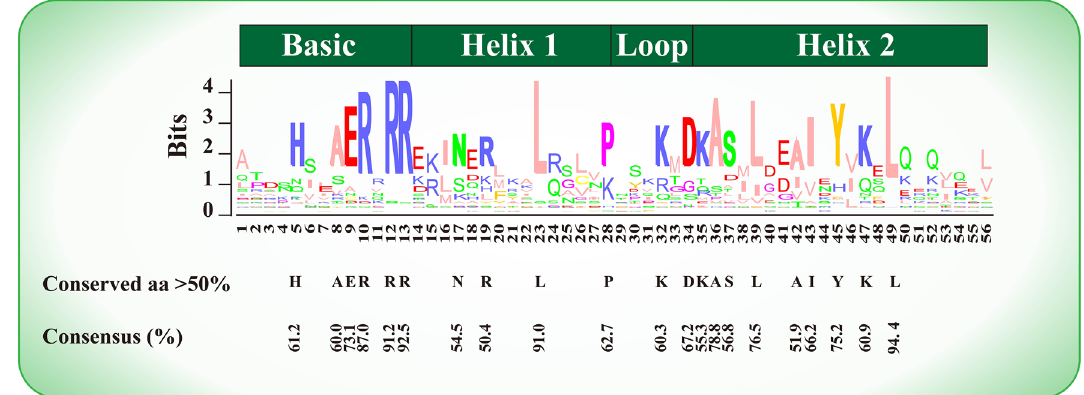
Figure 1. Conserved residue analysis of bHLH domains. The height of each residue indicates the conservation rate. The black letters represent the residues with a consensus ratio greater than